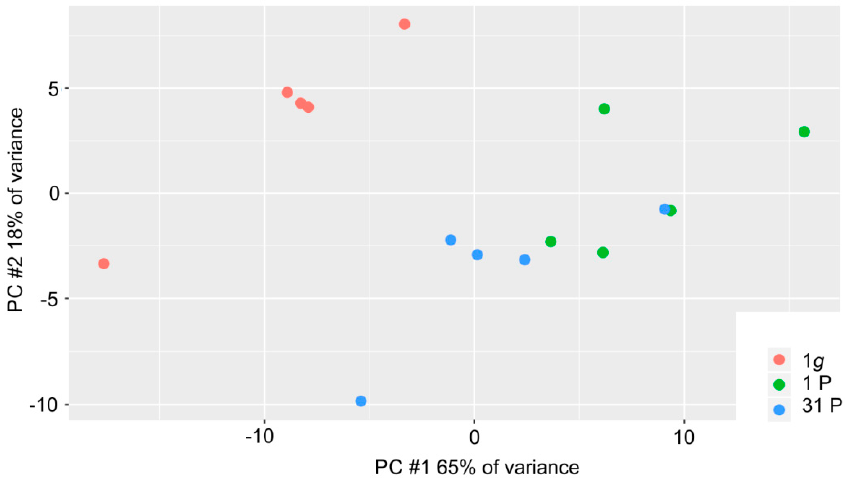
Figure 2. Distribution of the 15 PC-3 samples in the first two principal components; 1 g control samples, 1P and 31P inflight samples are color-coded in red, green and blue, respectively.